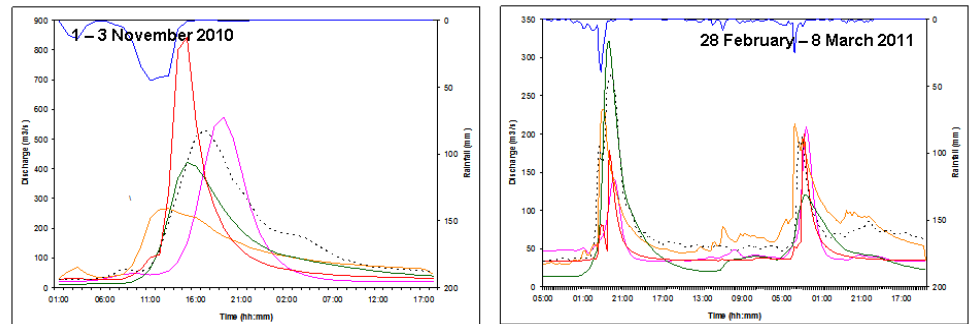
Figure 5. Hyetographs and hydrographs of the 10 rainfall–runo ff events observed and simulated using Figure 4. Hyetographs and hydrographs of the 10 rainfall–runoff events observed and simulated four hydrological models in the Mesima torrent (Calabria, using four hydrological models in the Mesima torrent (Calabria, Italy).